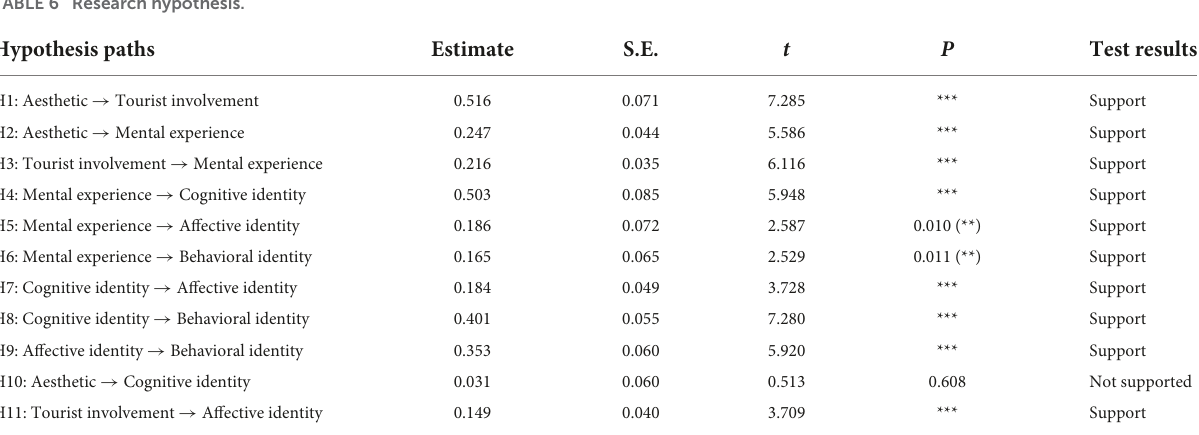
TABLE 6 Research